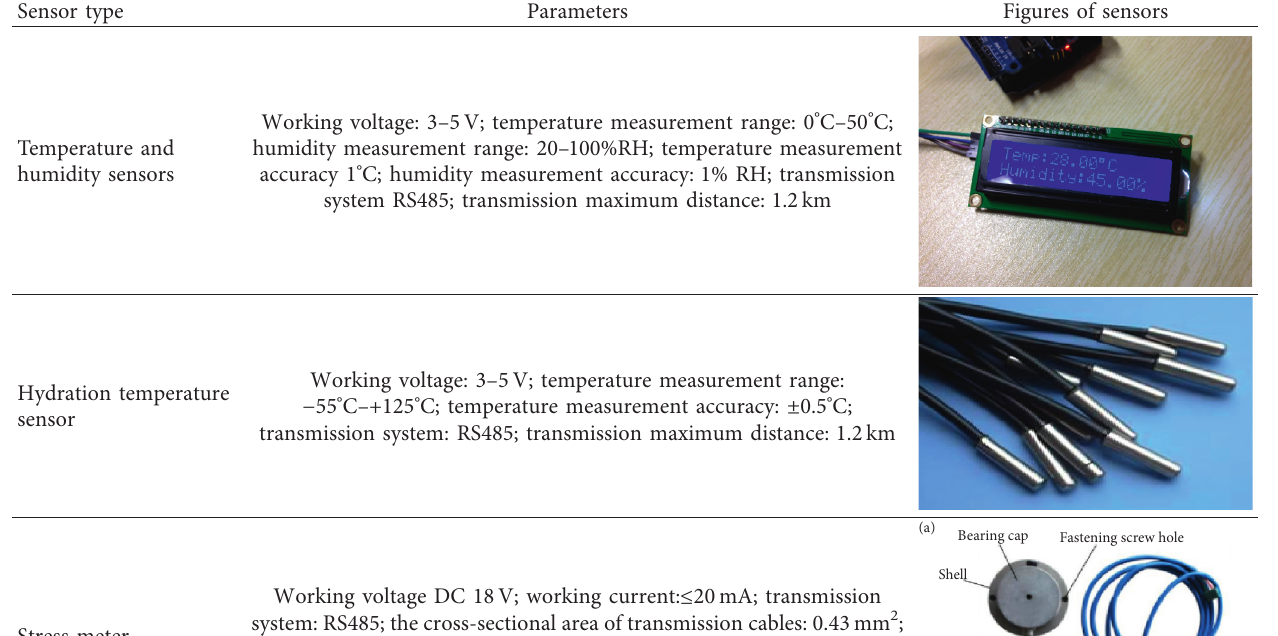
Table 2: Parameters of sensors.